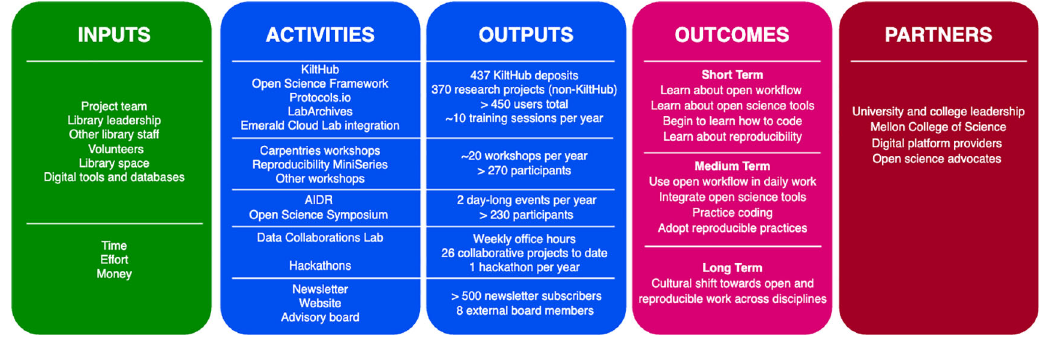
Figure 2. Graphic summary of a logic model. A logic model was created by listing inputs, activities, outputs, outcomes, and partners for each activity and creating a narrative. A simplified graphic summary was created to representessentialelementsofthelogicmodel.Inputs:resourcesrequiredforallactivities.Activities:thefivegroups of activities in the OSDC program; from top to bottom: tools, workshop, events, collaboration, and outreach. Outputs: product of each activity. Outcomes: short-, medium-, and long-term goals. Partners: partnerships formed to date. Emerald Cloud Lab: a remote controlled, automated lab where equipment is run remotely and workflow, data and code are automatically recorded; Reproducibility MiniSeries: short format workshop series that currently include R and